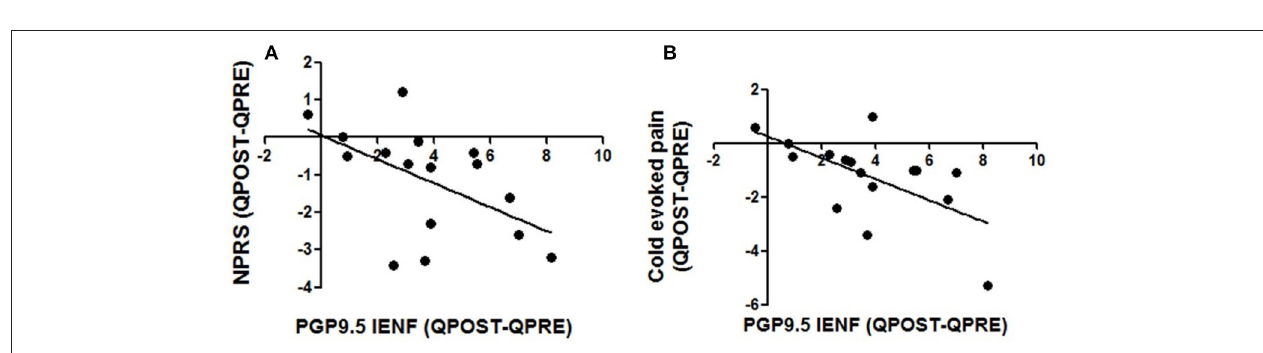
FIGURE 5 | Correlations between changes in intra-epidermal nerve fibre density and pain relief. Decrease in pain scores in spontaneous pain (A) and cold evoked pain (B) were correlated with changes in density of PGP 9.5 nerve fibres 3 months after the application of Capsaicin 8% patch, Spearman test; p values were respectively p = 0.027 and p =